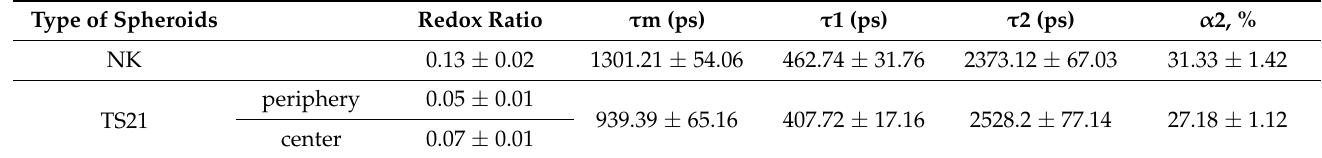
Table 3. Data on the redox ratio and FLIM parameters in TS21 and NK spheroids (mean ± SD, p = 10 − 6 ). Type of Spheroids NK